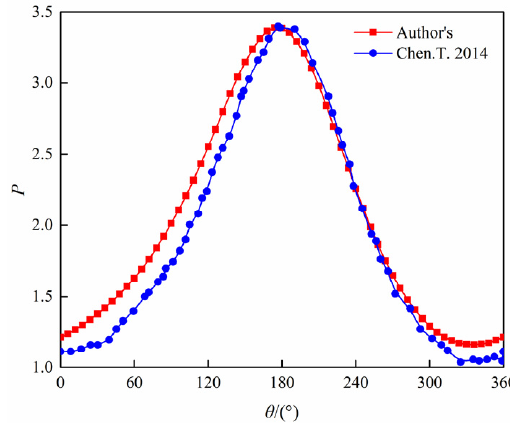
Figure 5. Computational program verification [29].